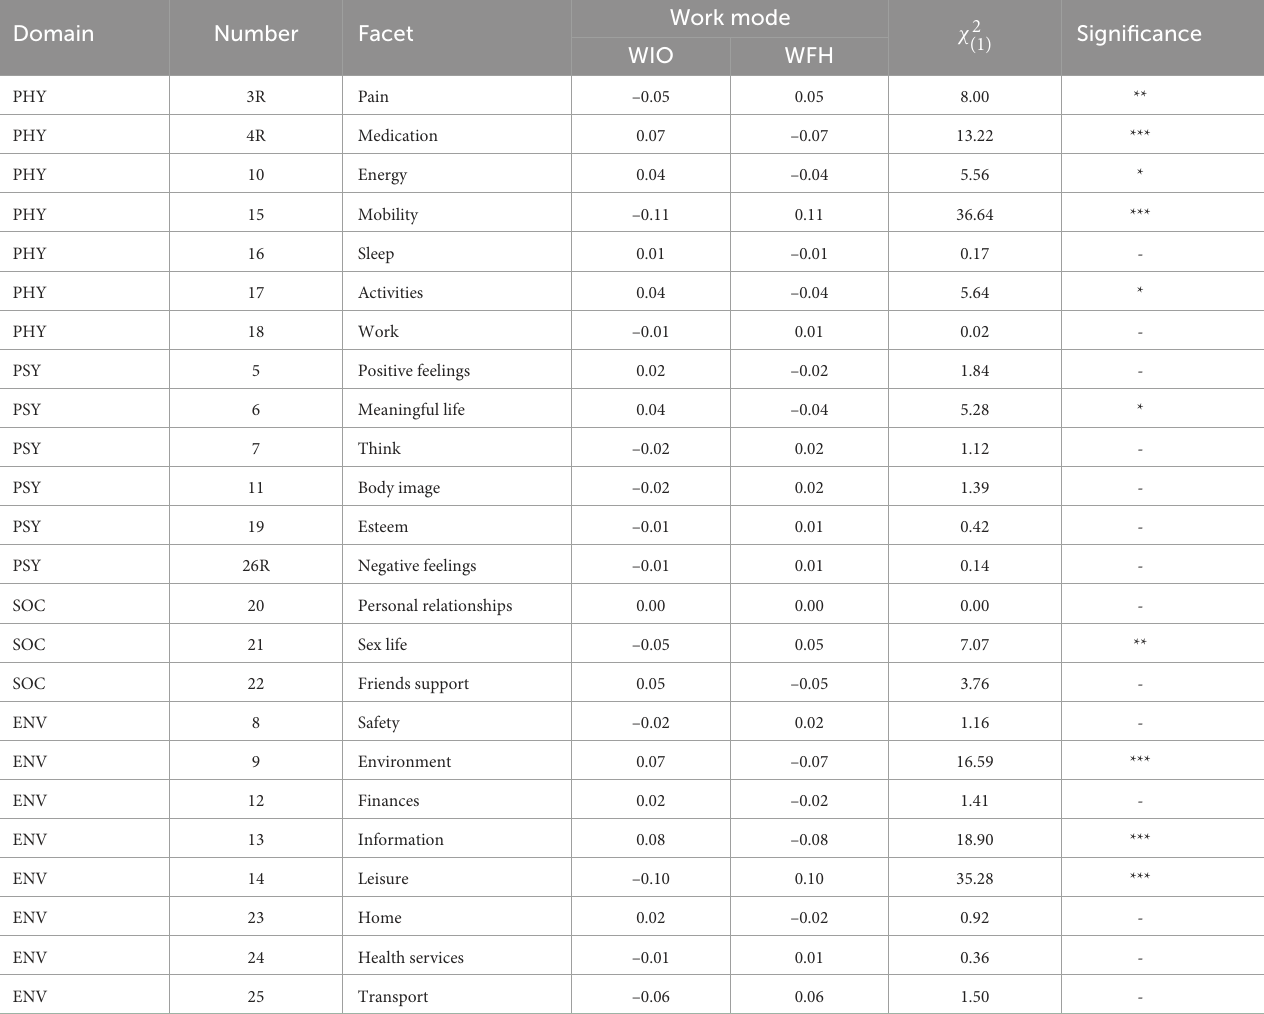
TABLE 3 Summary table for the DIF analysis in the items of WHOQOL-BREF across subgroups of the work mode.